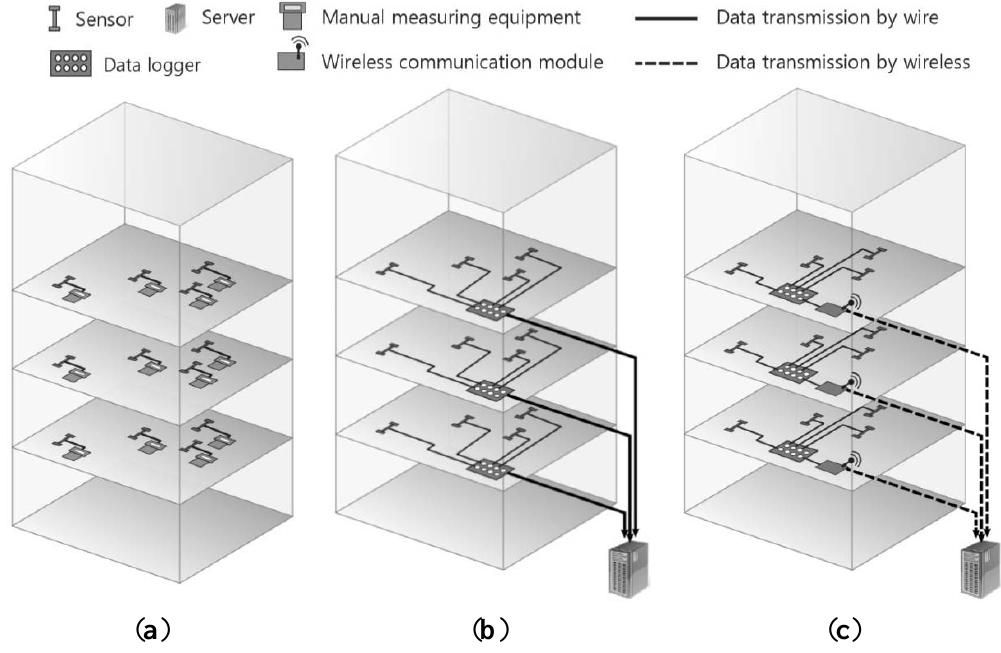
Figure 1. Existing systems for the measurement of column shortenings in a